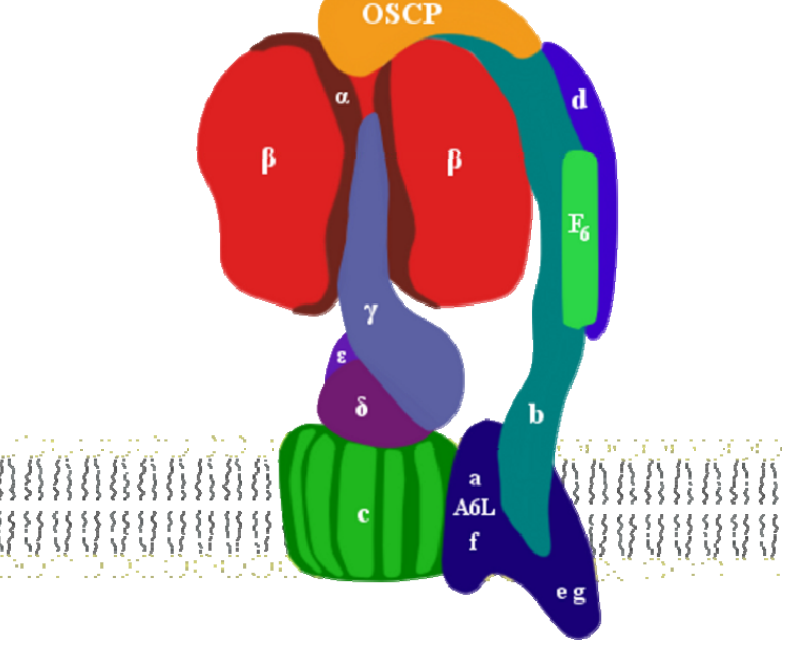
F ATP synthase as a O 1